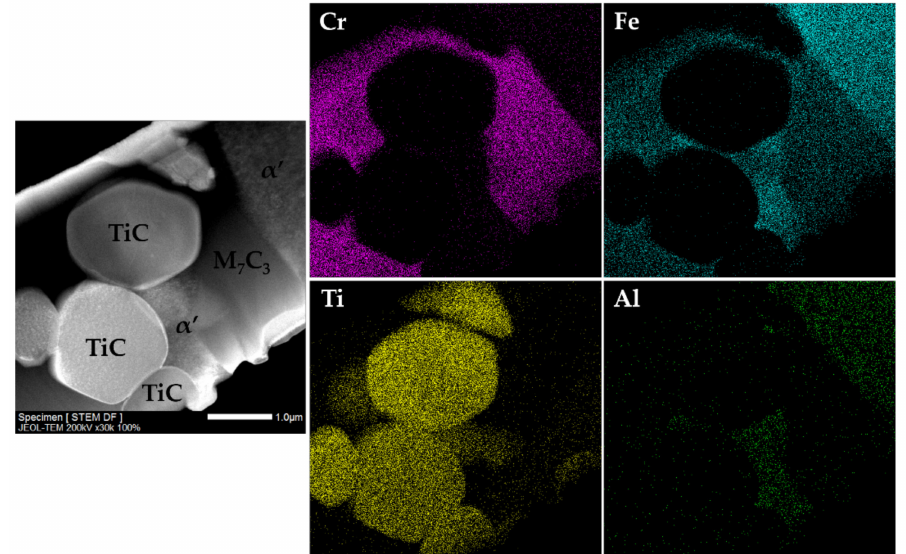
Figure 16. Dark-field STEM image of the composite zone and the EDS maps of Cr, Fe, Ti, and Al from the correspondent